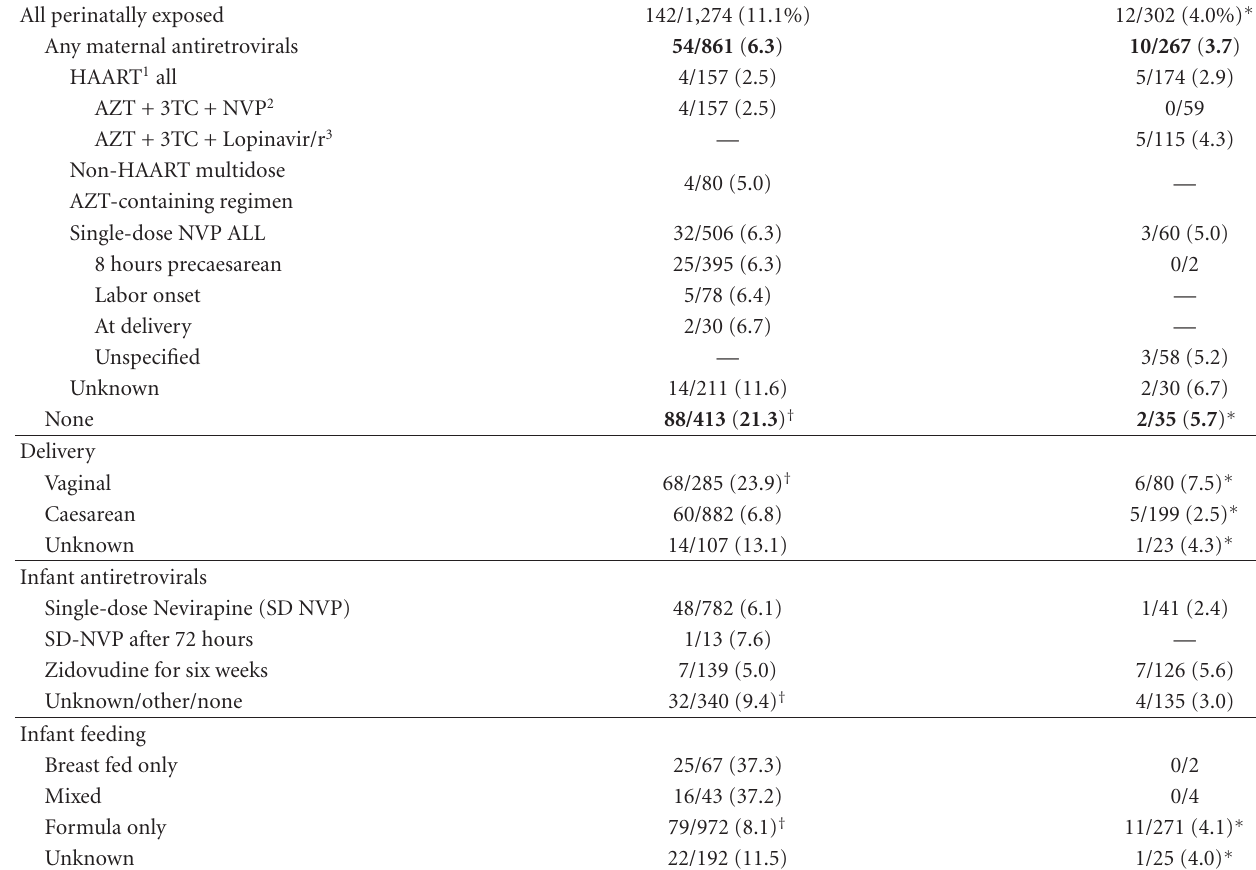
Table 2: HIV mother-to-child transmission risk in the 1999–2008 and 2009–2011 periods, by prenatal antiretroviral, delivery route, and infant feeding prevention strategies, Dominican